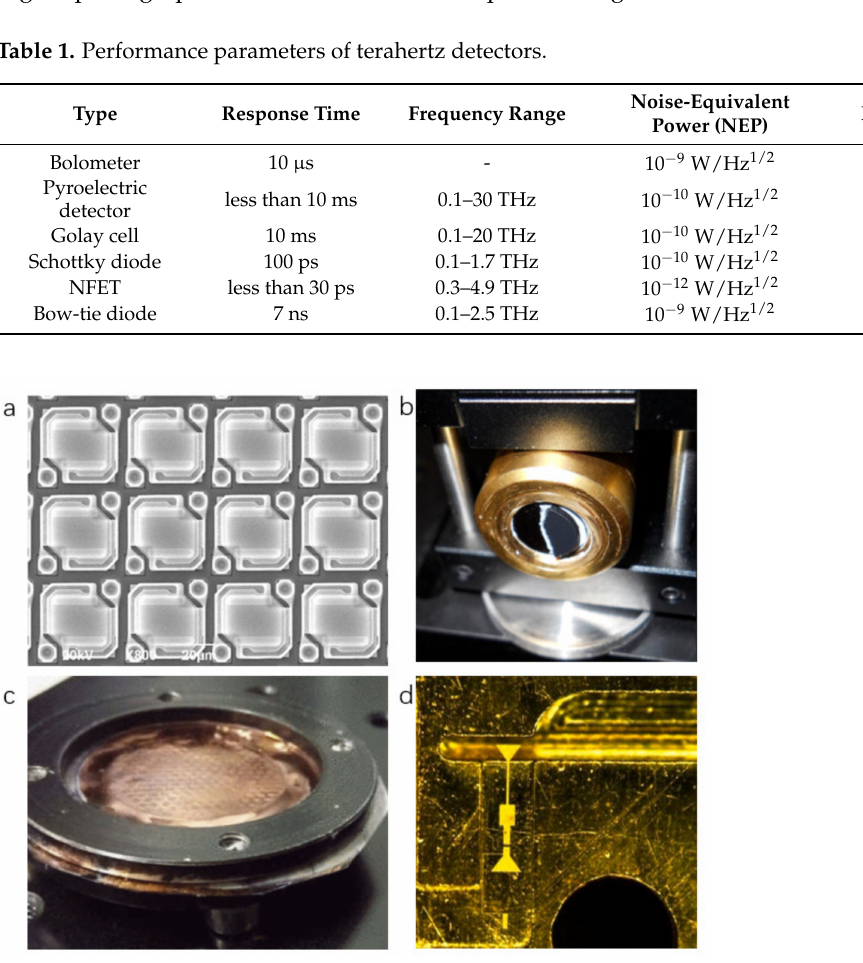
Figure 1. ( a ) The image of Bolometer array. Reprinted with permission from ref. [33]. Copyright 1969 Elsevier. ( b ) Appearance of pyroelectric detector. Reprinted with permission from ref. [34]. Copyright 2021 Copyright Clearance Center. ( c ) Appearance of Golay cell. Reprinted with permission from ref. [35]. Copyright 2021 Copyright Clearance Center. ( d ) Photograph of Schottky diode. Reprinted with permission from ref. [36]. Copyright 2021 Copyright Clearance